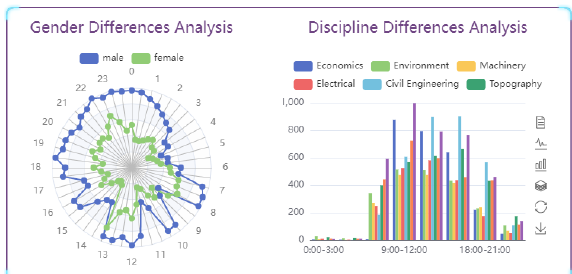
Figure 9 . Differences in user